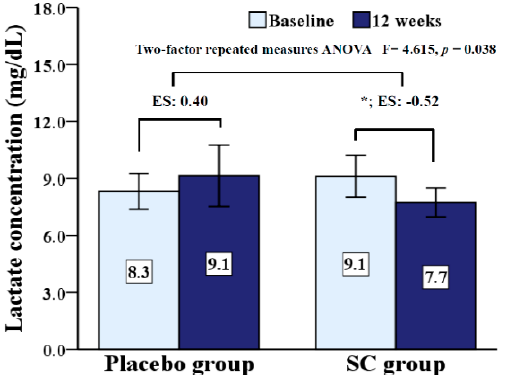
Figure 2. Comparisons of lactate concentration at baseline and 12 weeks after age adjustment. SC: Schisandra chinensis ; ES: effect size; * p < 0.05 versus between baseline and after intervention.4. Discussion